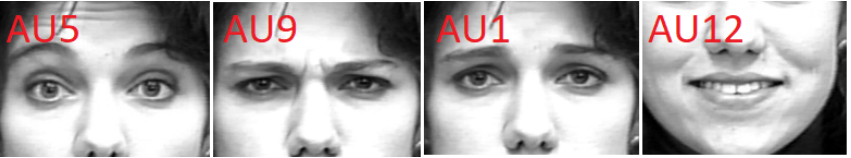
Figure 16. Some relevant examples of AUs for facial expression